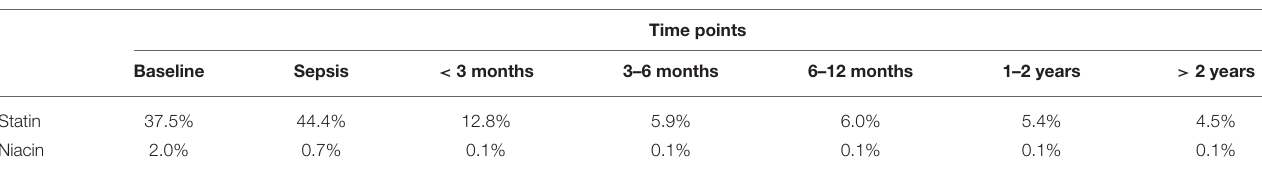
TABLE 3 | Frequency of statin and niacin use in each study